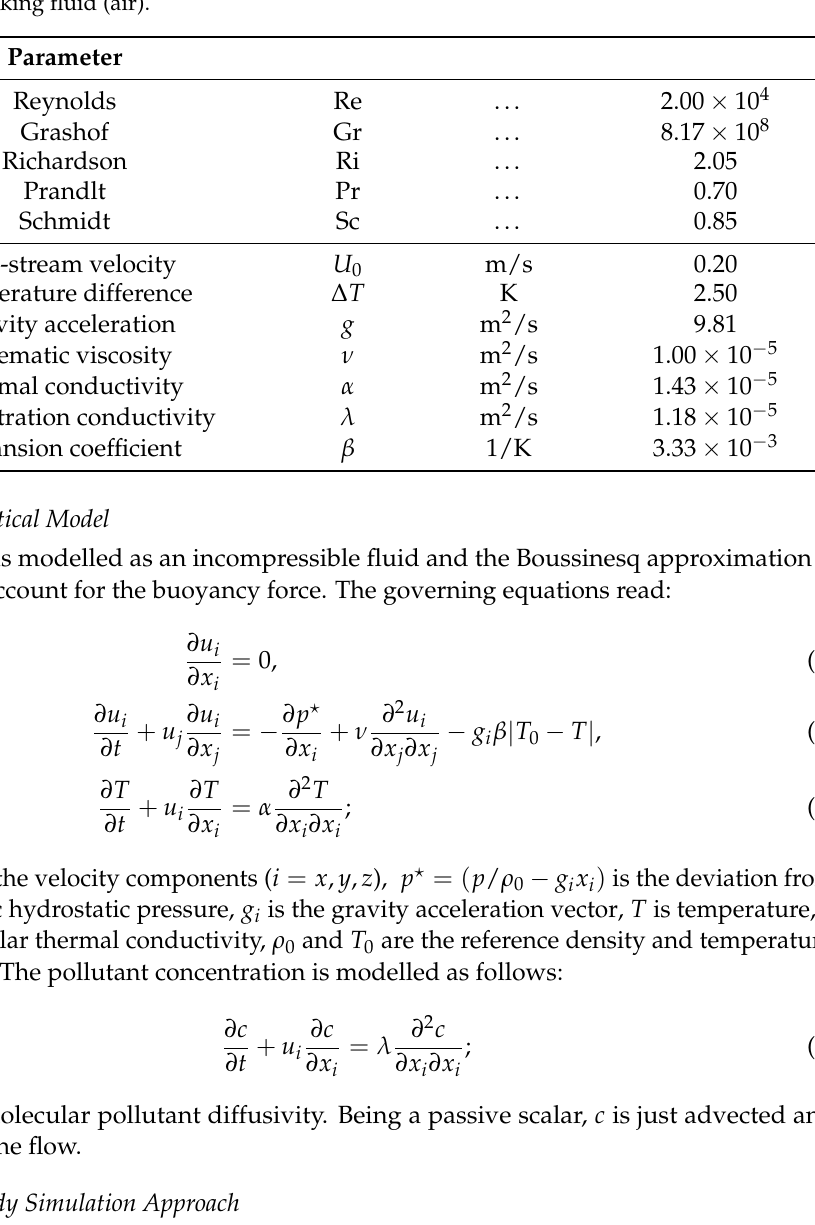
Table 1. Non-dimensional numbers that characterised the case study and thermo-dynamic parame- ters of the working fluid